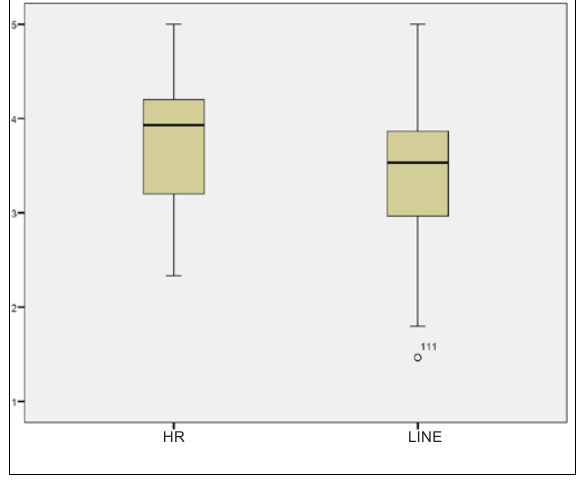
FIGURE 2 Group comparisons between HR and line on operational excellence